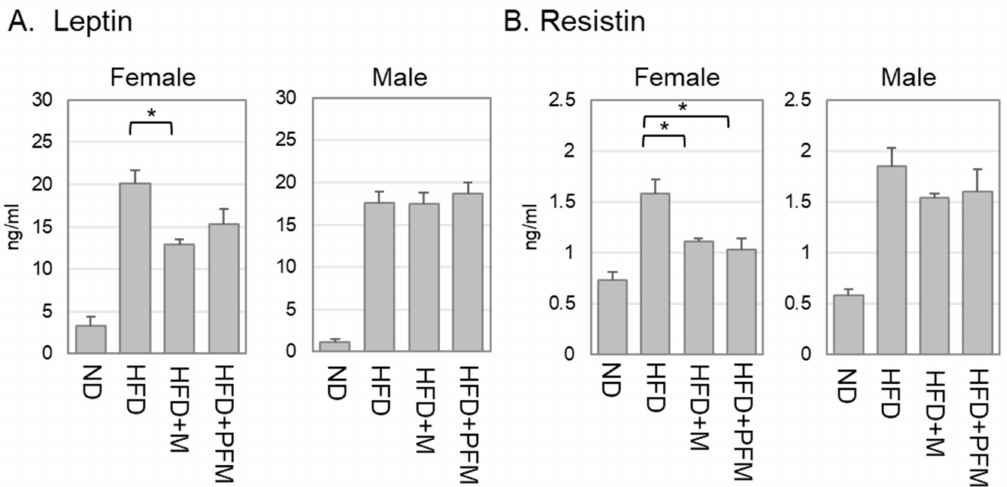
Figure 4. The reduction in leptin and resistin levels by the consumption of miso and PFM. The levels of leptin ( A ) and resistin ( B ) in the serum from mice. Error bars indicate S.E. ( n = 5 or 6). Values with different superscripts are significantly different among HFD groups by ANOVA with Tukey’s multiple comparison test. * p < 0.05.